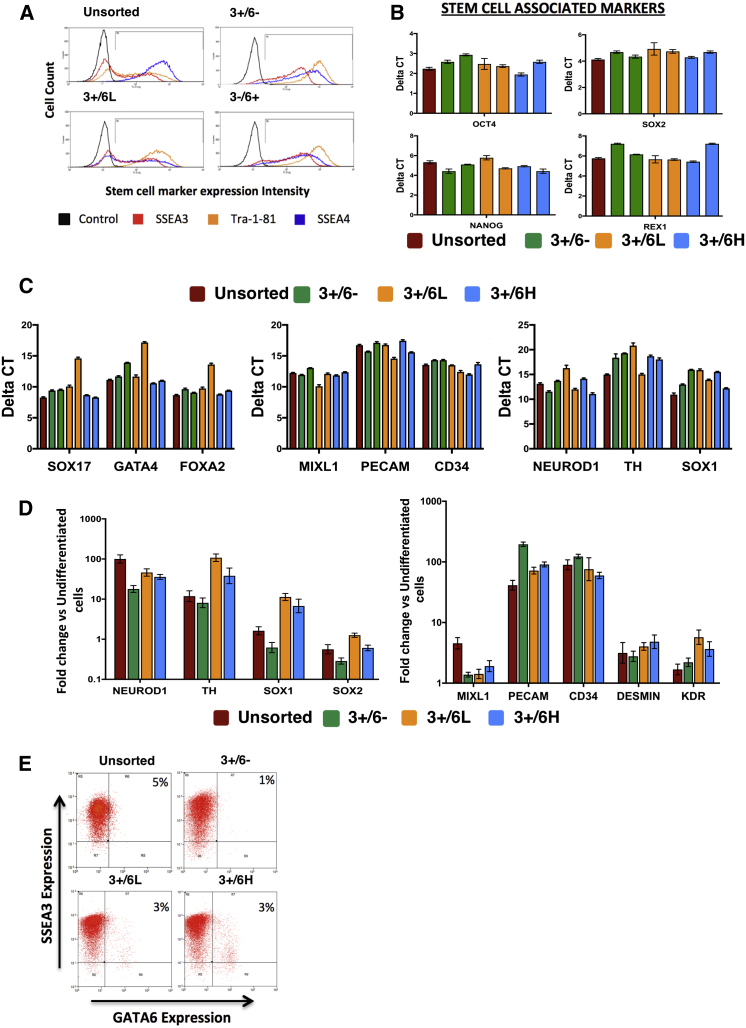
Stable, Long-Term Self-Renewing hESC Subclones Can Be Derived from GATA6-Expressing Cells(A) Flow cytometric analysis of subclones derived from the 3+/6−, 3+/6L, and 3+/6H fractions. Unsorted represents the unsorted cells of the reporter line. P3X was used as a negative control, and markers SSEA3 (red), TRA-1-81 (orange), and SSEA4 (blue) were used to identify stem cells. FACS plots show one clone from each fraction, which is representative of four clones analyzed from each fraction.(B) qPCR analysis of two subclones from each fraction for core stem cell transcription factors, shown as Delta-CT normalized to beta-actin; error bars are the SD from three technical repeats. Red bar represents the reporter line, and individual 3+/6−, 3+/6L, and 3+/6H subclones are shown by green, orange, and blue bars, respectively.(C) qPCR for lineage-specific markers of each germ layer in unsorted (red) and two subclones from each fraction. Bar color as in (B), showing Delta-CT normalized to beta-actin with three technical repeats.(D) qPCR of day 10 EBs from unsorted (red), and subclones from 3+/6− (green), 3+/6L (orange), and 3+/6H (blue) fractions for genes specifying mesoderm (left panel) and ectoderm (right panel) to demonstrate pluripotency of the lines. Data shown as fold change against undifferentiated cells from the same starting population. Error bars are SD of three technical repeats.(E) Flow cytometric analysis of reporter line (top left) and 3+/6− (top right), 3+/6L (bottom left), and 3+/6H (bottom right) subclones for SSEA3 versus GATA6 expression 5–8 passages after initial single-cell seeding. Gates were set using P3X and Shef4 parental line as SSEA3 and GFP negative controls respectively. Plot shows one clone representative of four clones analyzed from each fraction.